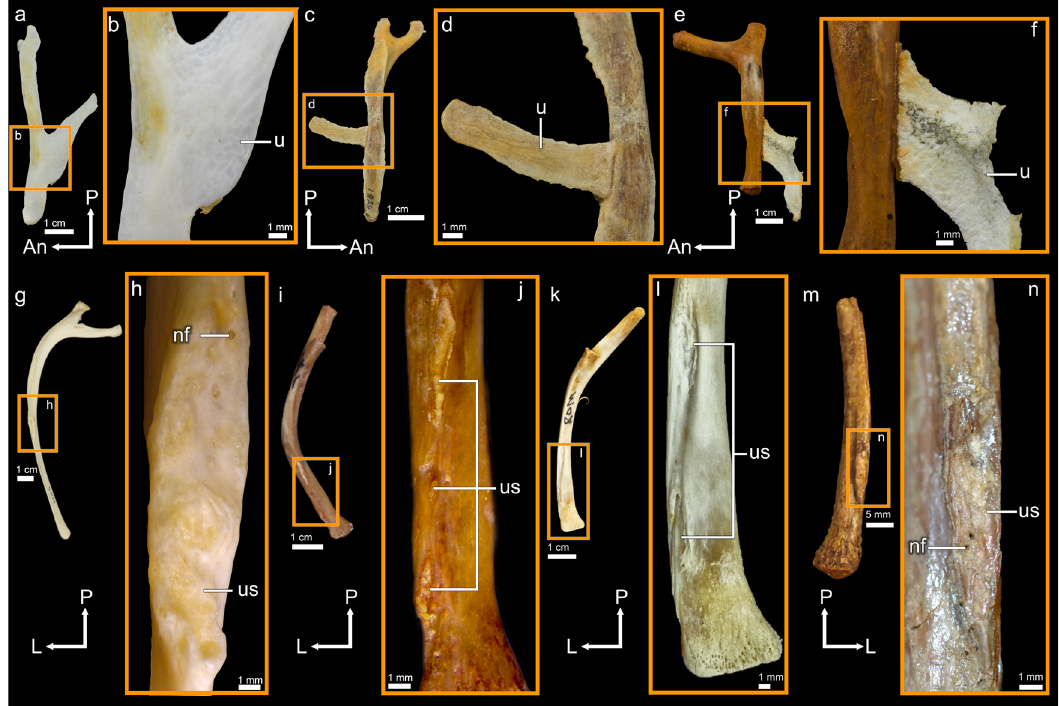
Fig. 1 Dorsal vertebral ribs with uncinate processes and uncinate scars in extant archosaurs, and vertebral rib with uncinate scar in an indeterminate fossil crocodylian. Left dorsal vertebral rib of the bald eagle Haliaeetus leucocephalus (UAMZ 5028) in lateral view ( a ), and close-up of contact between dorsal vertebral rib and uncinate process in lateral view ( b ); right dorsal vertebral rib of the skeletally immature wild turkey Meleagris gallopavo (UAMZ 1824) in lateral view ( c ), and close-up of contact between dorsal vertebral rib and uncinate process in lateral view ( d ); left dorsal vertebral rib of the alligatorid crocodylian Caiman crocodilus (UAMZ unnumbered) in lateral view ( e ), and close-up of contact between dorsal vertebral rib and cartilaginous uncinate process in lateral view ( f ); left dorsal vertebral rib of the palaeognath bird Rhea americana (UAMZ 5019) in posteromedial view ( g ), and close-up of uncinate scar in posterior view ( h ); left dorsal vertebral rib of C. crocodilus (UAMZ unnumbered) in posteromedial view ( i ), and close-up of uncinate scar in posterior view ( j ); left dorsal vertebral rib of C. crocodilus (ROM R7077) in posteromedial view ( k ), and close-up of uncinate scar in posterior view ( l ); incomplete right vertebral rib of indeterminate fossil crocodylian from the Miocene of Florida, USA (AMNH 7900) in posteromedial view ( m ), and close-up of uncinate scar in posterior view ( n ). Branching lines indicate multiple rugose areas of a single uncinate scar separated by smooth cortex. An anterior, L lateral, nf nutrient foramen, P proximal, u uncinate process, us uncinate